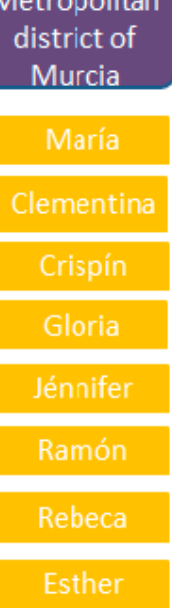
Figure 1. Forenames bearing religious connotations in the metropolitan district of Murcia.